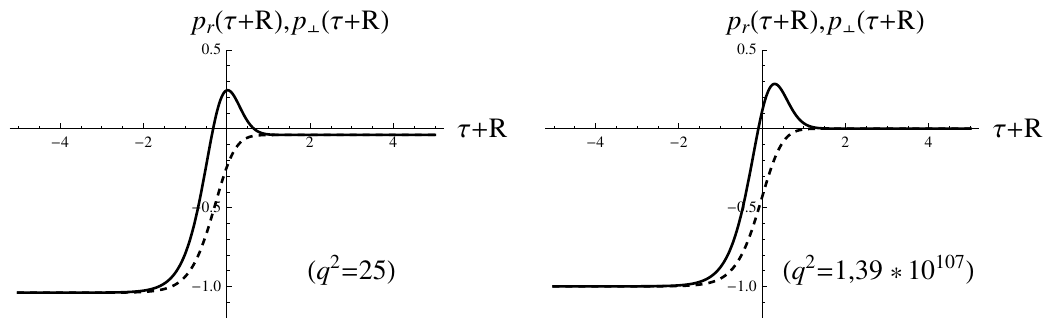
Figure 3. Typical behavior of pressures. The radial pressure p r is plotted with the dashed line and the transversal pressure p ⊥ is plotted by the solid